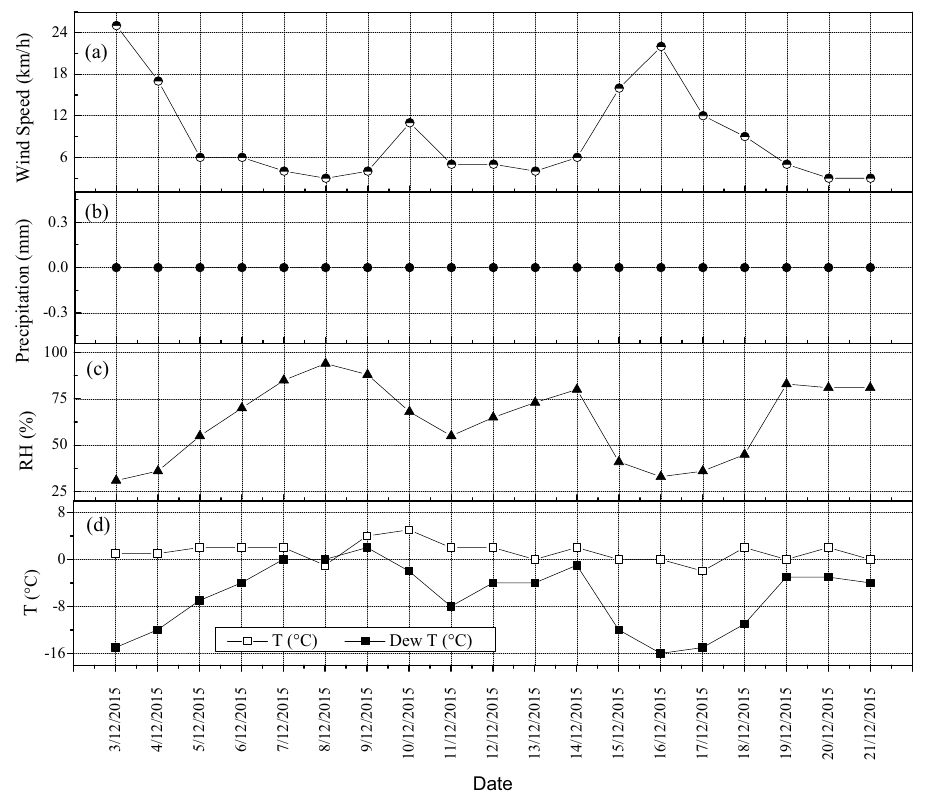
Figure 3. Meteorological conditions during the period of this study.